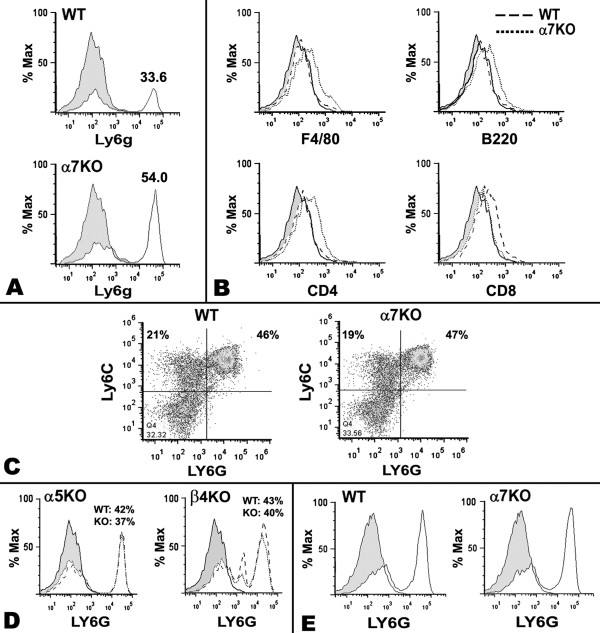
Croton oil treatment of α7KO mice selectively enhances neutrophil infiltration into ears 6 hours post-croton oil application. A) Flow cytometry of infiltrating cells from the α7WT (upper) or α7KO (lower) mice reveals a substantial difference in the infiltration by Ly6G+ neutrophils 6 hours following croton oil treatment. Similar results were also obtained for C3H mice (data not shown). Histogram height is displayed as Percentage of Maximum (% Max), meaning that peak heights within each graph are normalized to a percentage of the peak representing the highest event number on the X axis. The percent of Ly6G positive cells is shown above the peak response. At least 3 independent experiments, each containing 5 mice per group, are shown and isotype controls for all antibodies showed a staining pattern identical to the unstained controls (shaded histogram). B) Infiltrating cells stained with other immune cell markers for α7WT and α7KO genotypes. C) Bone marrow granulocytes of α7WT and α7 KO mice double labeled for Ly6G and the more immature marker, Ly6C (granulocytes and neutrophils). Unlike infiltrating cells to the skin, these cells do not differ in resident bone marrow populations. D) Similar to Panel A, either α5KO mice or β4KO mice with corresponding WT controls were examined for Ly6G recruitment to the skin. The grey shaded histogram represents control unstained cells. E) Cells from ears of α7WT and α7KO mice were harvested 24 hours post application of croton oil. Results reflect similar numbers of Ly6G positive cells at this later time.